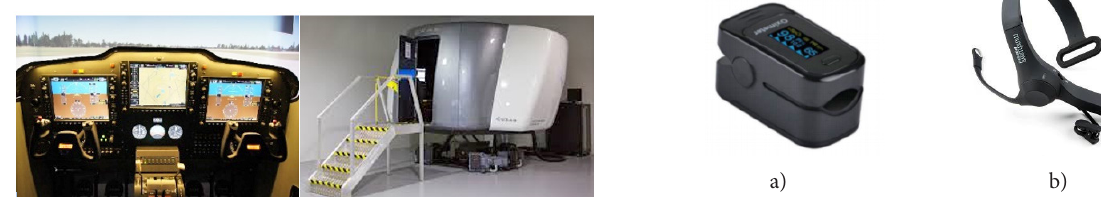
Figure 1. CKAS MotionSim5 simulator